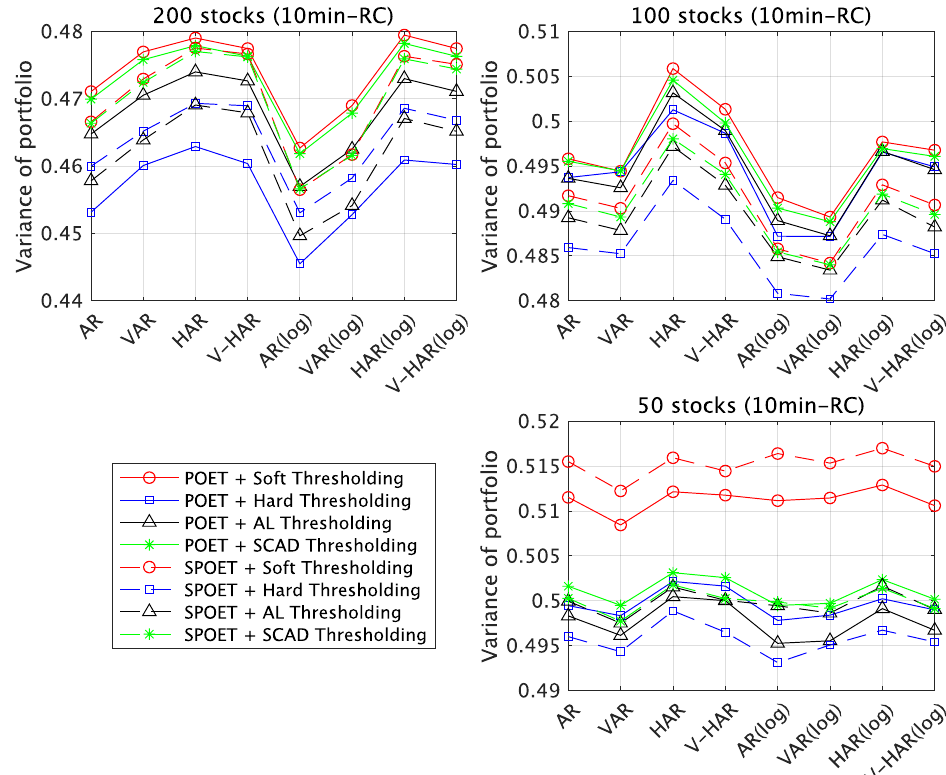
Figure 3. The variance of portfolios estimated by each model using 10-min interval intraday